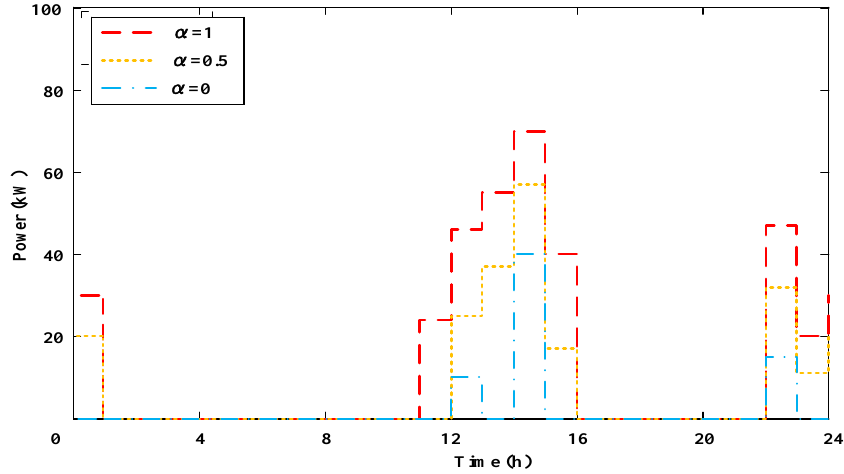
Figure 6. Optimal down-spinning reserve capacity of a system (renewable energy penetration rate is 30%).